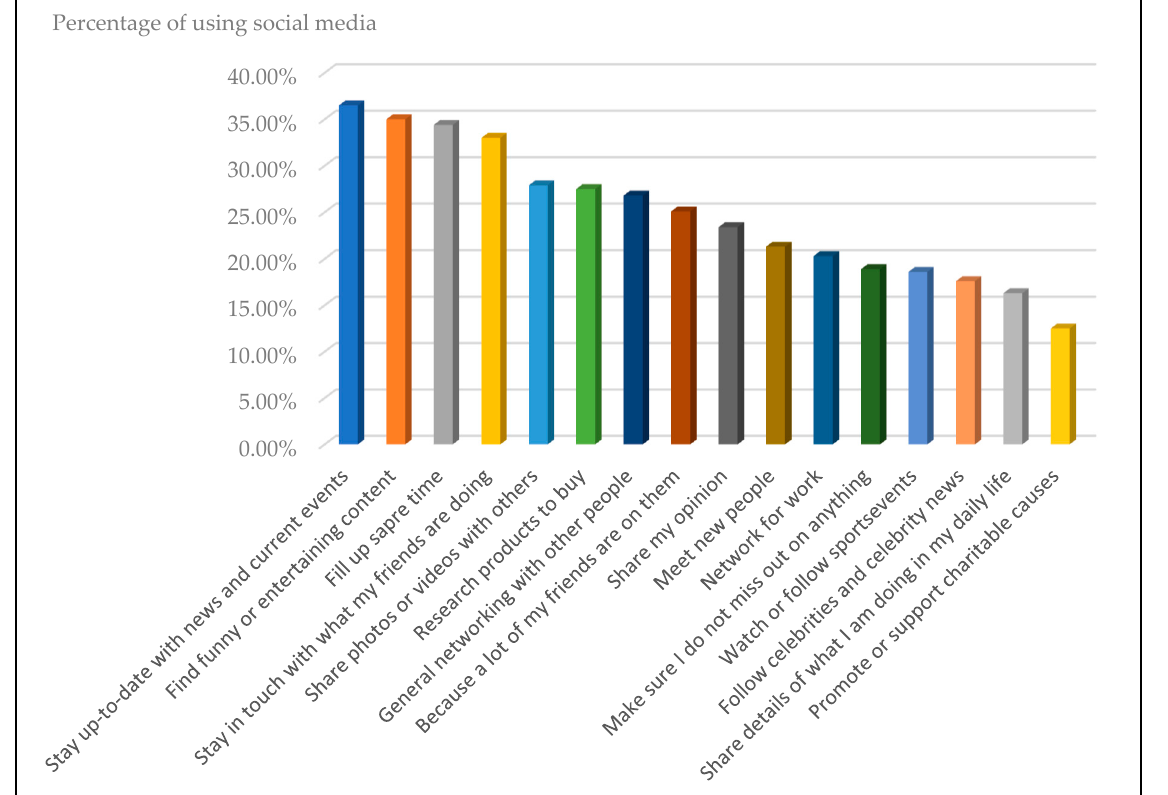
Figure 2. The reasons for using social media according to the Digital 2021 Global Digital Overview report [48].